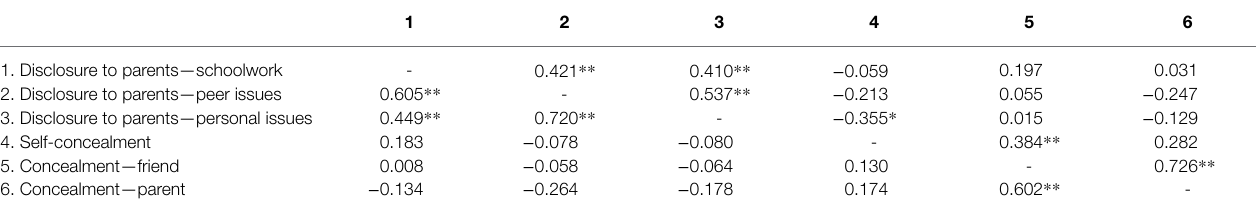
TABLE 1 | Correlations between disclosure and concealment variables.